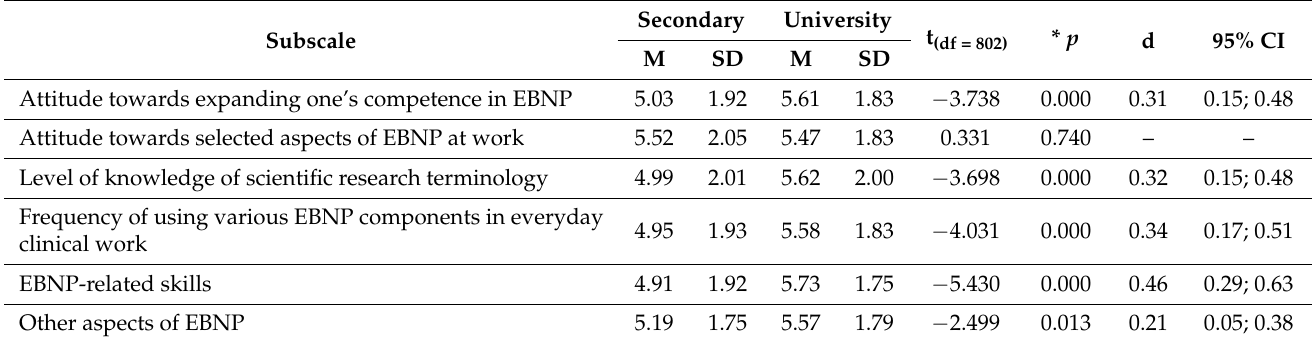
Table 5. Impact of the respondents’ educational background on the knowledge of, attitudes toward, and skills in EBNP according to the EBPPQ.